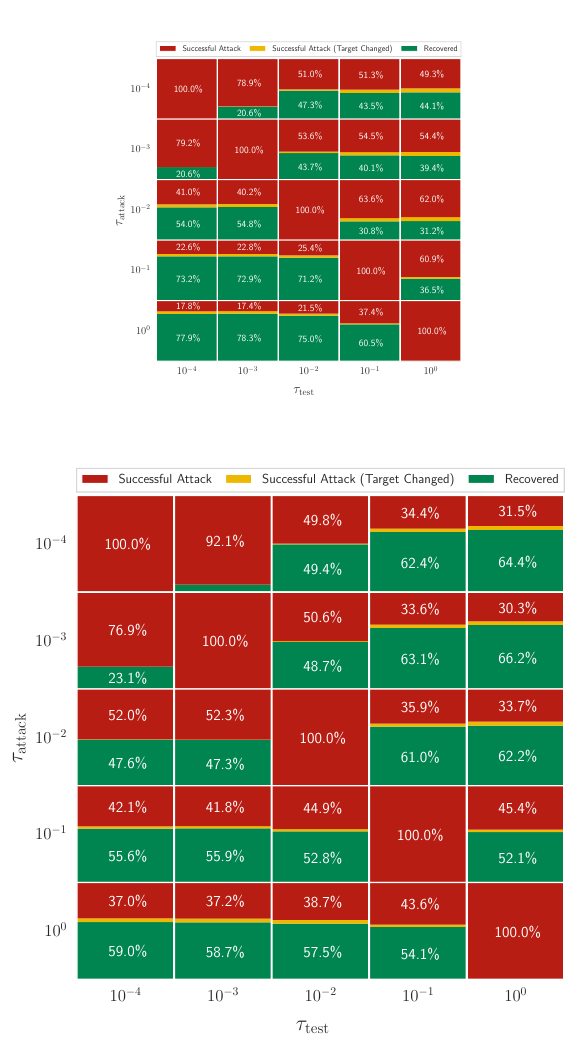
Figure 5. Attack success rate (in red) and recovery rate (in green) when varying τ attack (on y -axis) and τ test (on x -axis). In yellow, the percentage of classifications that changed with respect to the one induced by the attack but are still